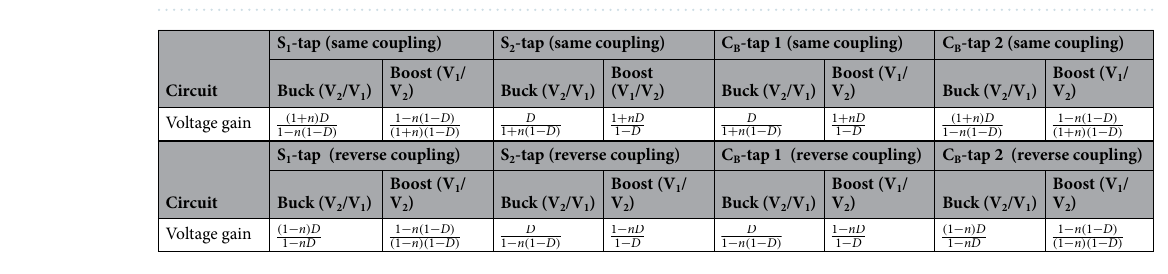
Table 1. The voltage gain M versus duty ratio D and the turn ratio n.